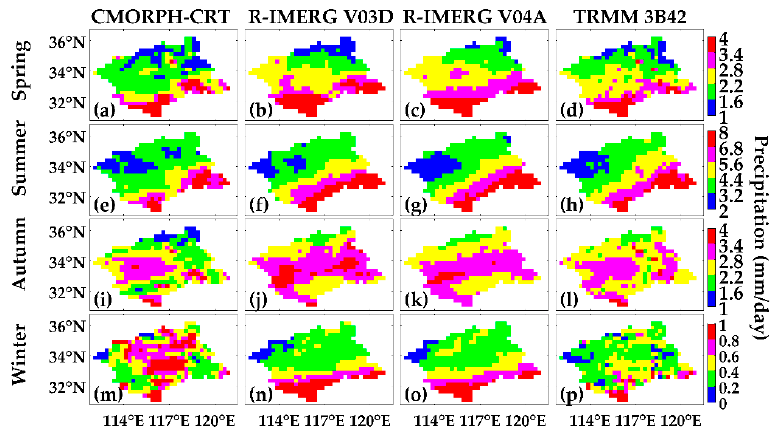
Figure 9. Maps of seasonal daily average precipitation (mm/day) at 0.25° resolution derived from CMORPH-CRT ( a , e , i , m ), R-IMERG V03D ( b , f , j , n ), R-IMERG V04A ( c , g , k , o ), and TRMM 3B42 ( d , h , l , p ) estimates for spring, summer, autumn and winter (from top to bottom) over the Huaihe River Basin between June 2014 and November 2015.